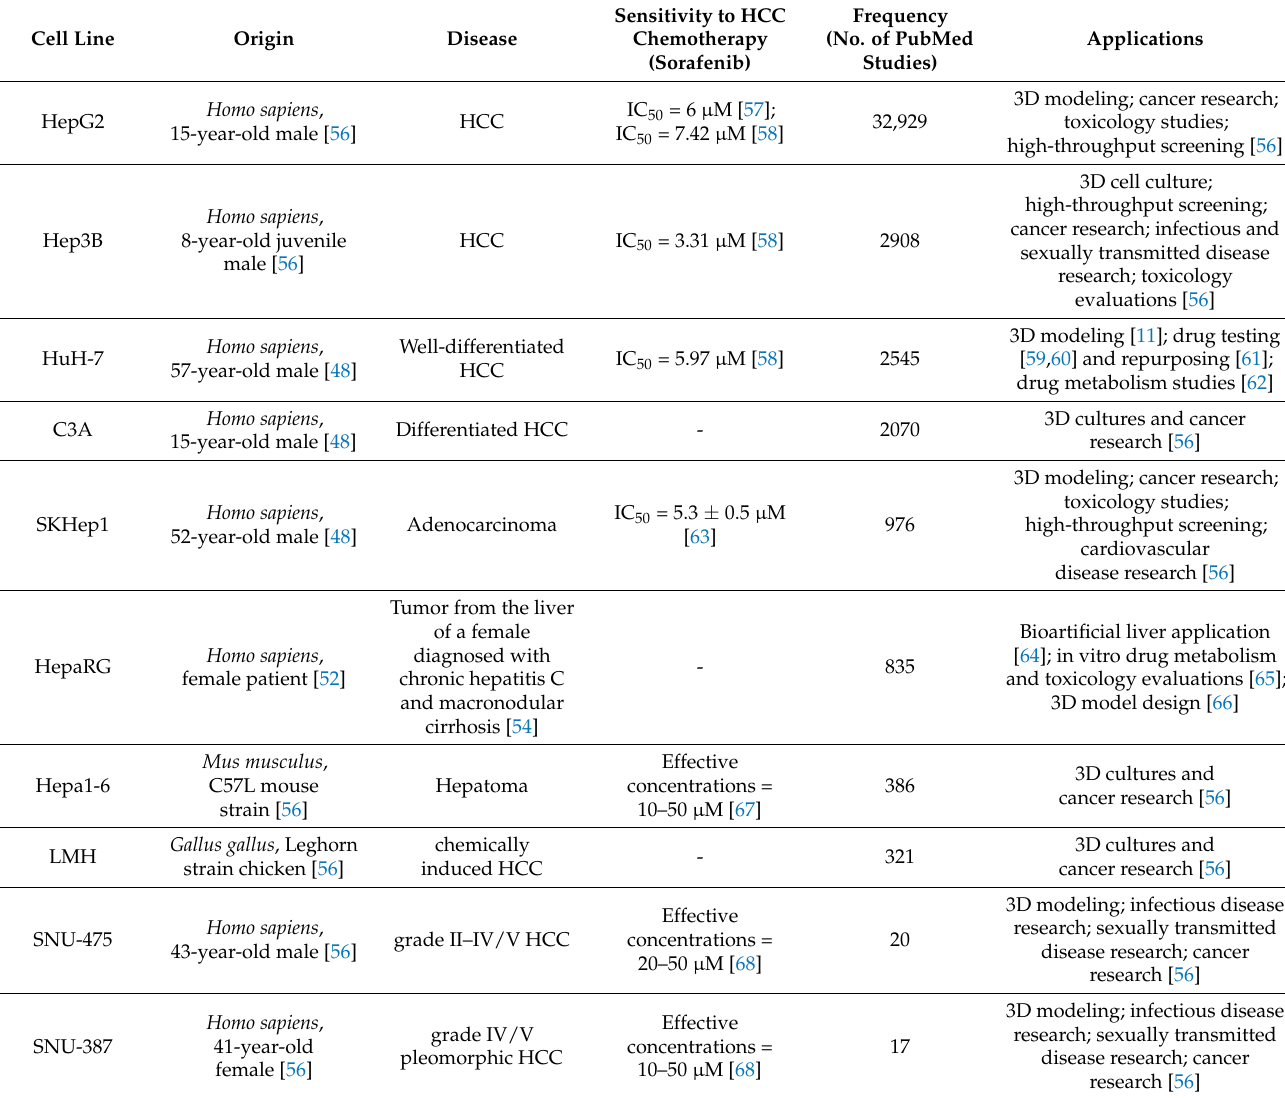
Table 1. Presentation of the cell lines currently described in the literature as established in vitro experimental models for HCC. Cell